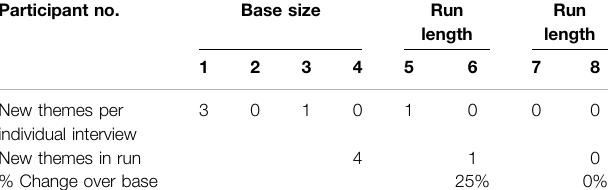
TABLE 2 | Saturation